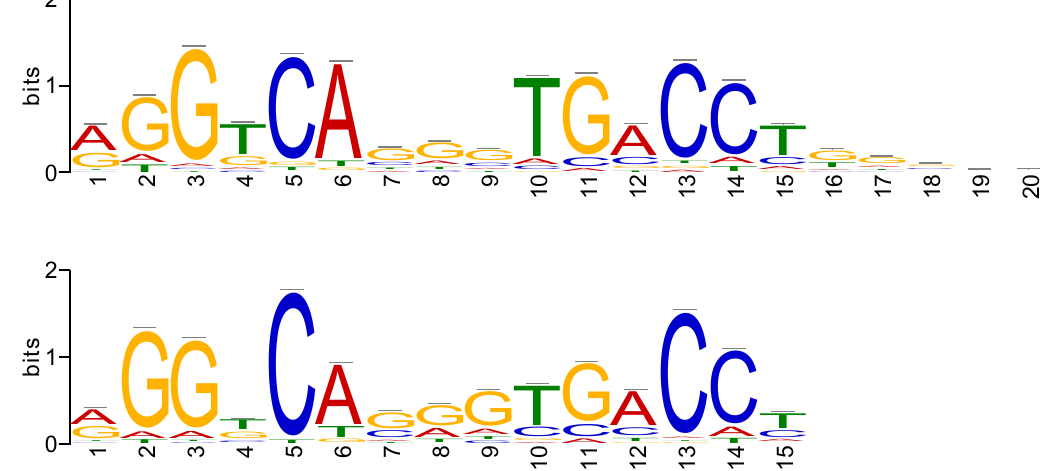
Figure 6: Top: ER binding site motif identified with CASSys . Bottom: The motif of ER- α from the JASPAR-database (accession number MA0112.2). Input for motif detection were the 200 most significant interaction sites extracted as described in the main text. All of these sites contained the shown